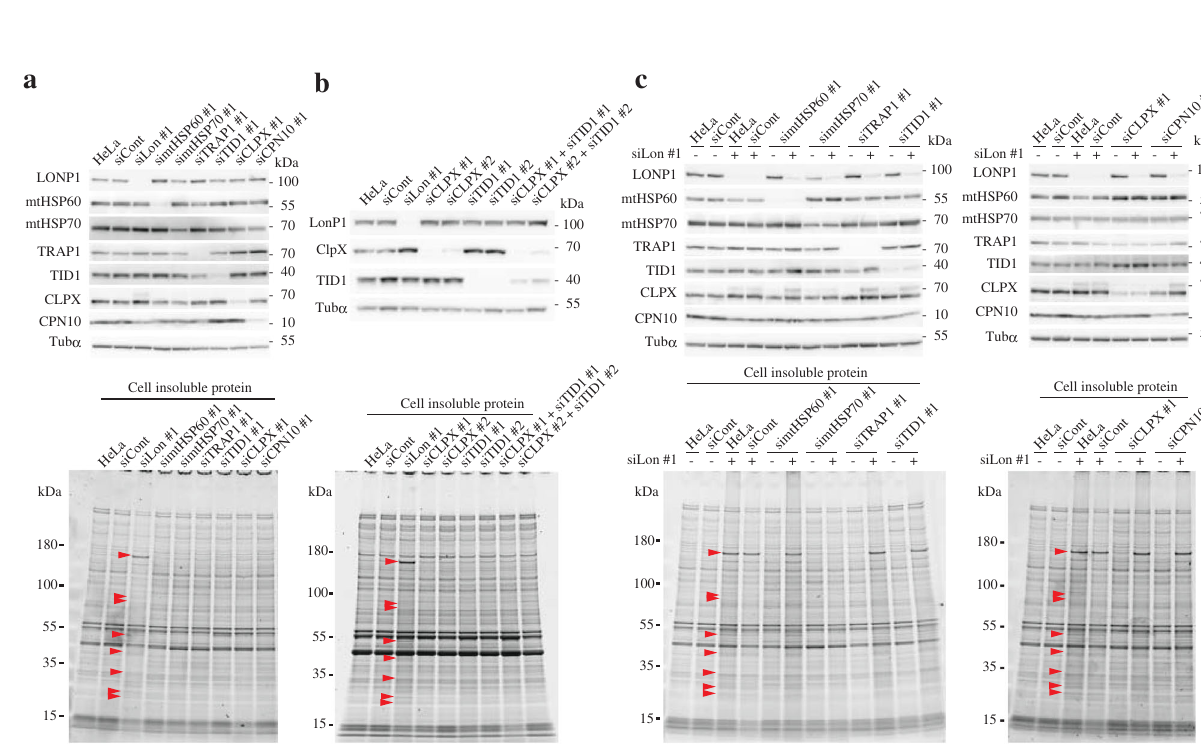
Fig. 2 The effects of depletion of mitochondrial chaperone proteins on protein aggregation. a Analysis of insoluble proteins from HeLa cells treated with Fig. 1a. Lower panel , comparison of insoluble proteins prepared from the cells, carried out as described in the legend to Fig. 1d. b Analysis of insoluble proteins from HeLa cells treated with siRNAs. Upper panel , immunoblot analysis of total proteins from double-knockdown HeLa cells. Lower panel , comparison of insoluble proteins prepared from the double-knockdown cells. The experiments were repeated twice and representative data are shown. c Upper panel , immunoblot analysis of total proteins from double-knockdown HeLa cells. Lower panel , comparison of insoluble proteins prepared from the double-knockdown cells. These experiments were repeated twice and representative data are